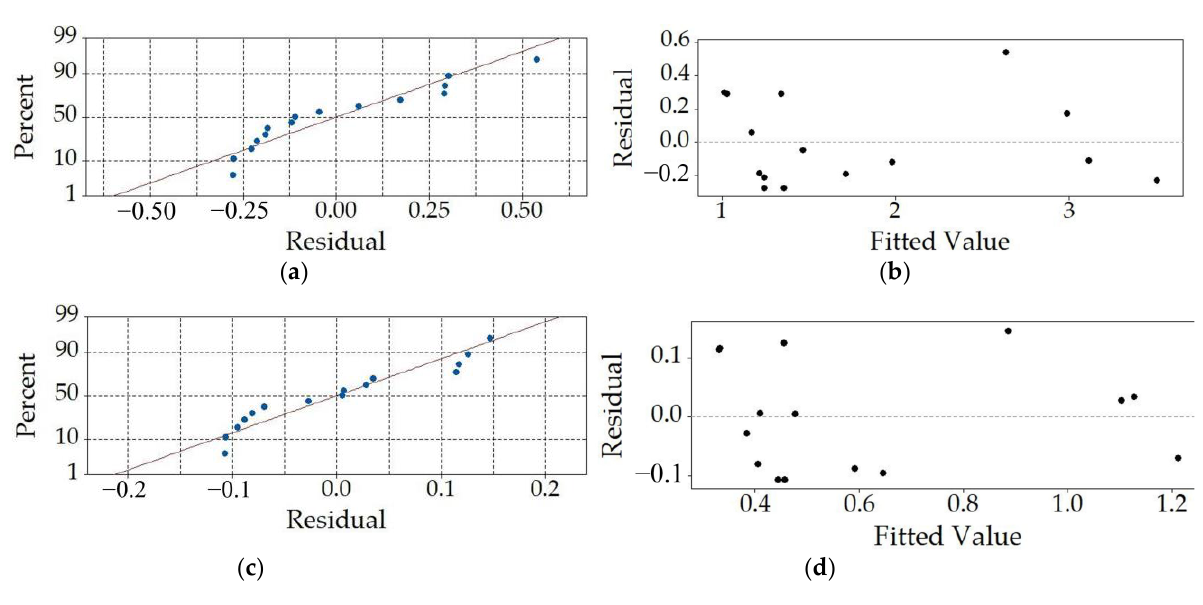
Figure 8. Average voltage values used to calculate different average PEH power outputs.